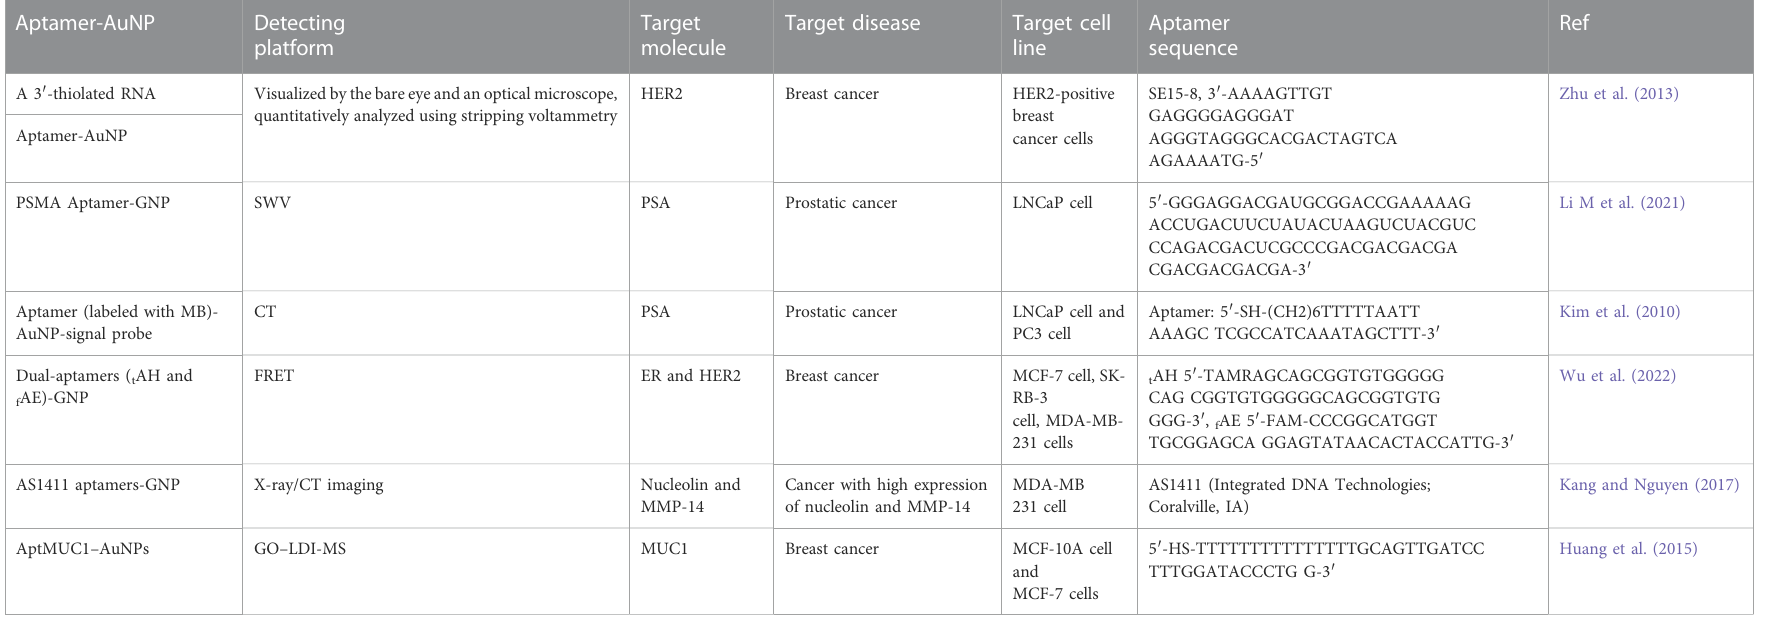
TABLE 1 Apatamer-AuNP based detecting platforms for cancer